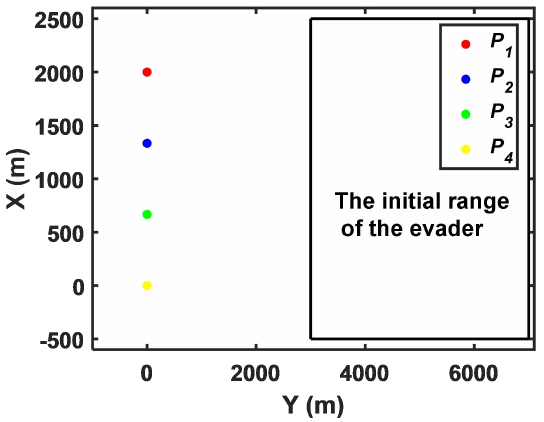
Figure 11. The initial range of the